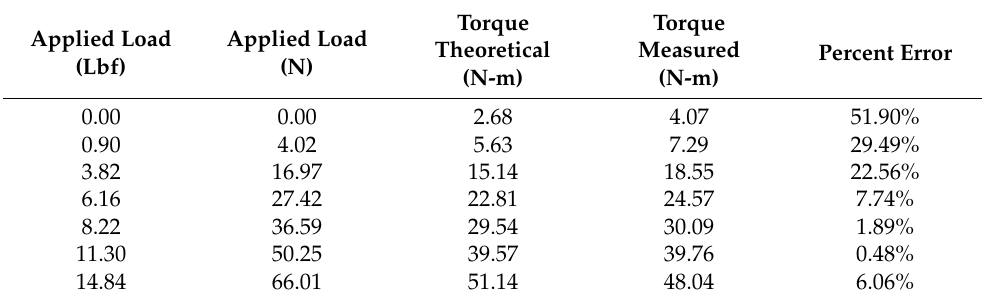
Table A9. The table shows the results from verifying torque applied to the Going Stick’s probe tip using the calibration rig for shear force.